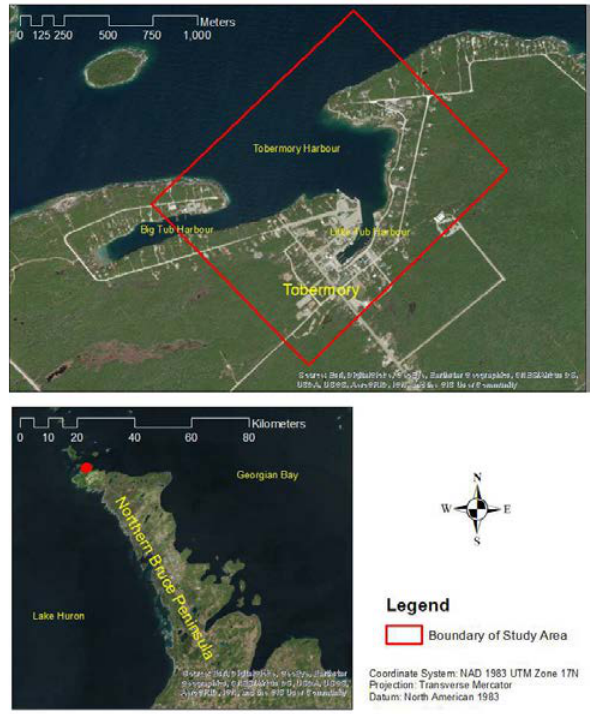
Figure 2. The study area in this research.